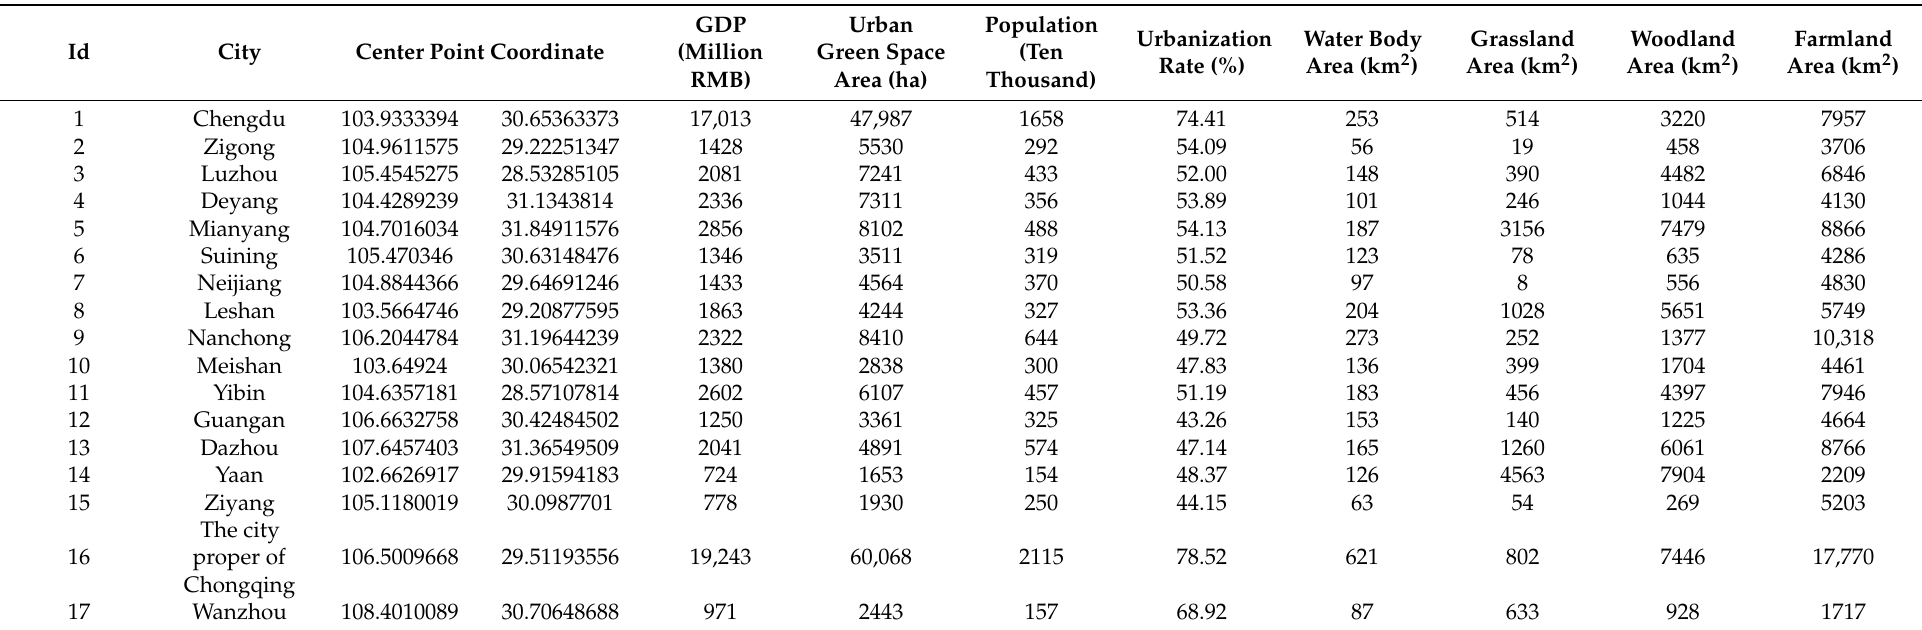
Table A1. Parameter values of gravity model. Data source: published yearbooks and land use/land cover data from the Data Center for Resources and Environmental Sciences, the Chinese Academy of Sciences (RESDC) (http://www.resdc.cn, accessed on 10 January